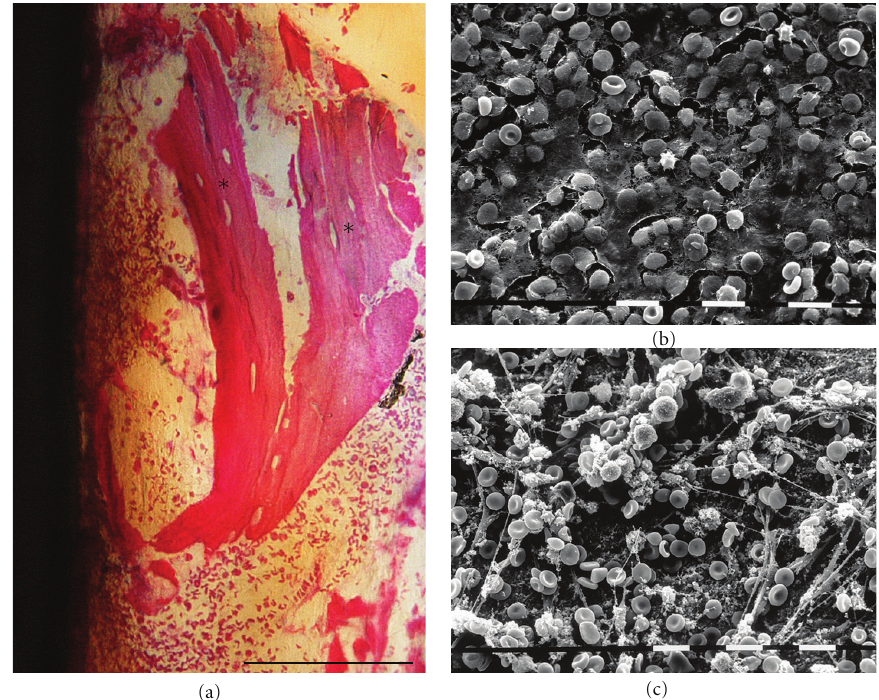
Figure 3: Day 0. Histology of longitudinal ground section (a). Empty osteocytic lacunae ( ∗ ). LM, toluidine blue, and acid fuchsin staining. Bar = 100 µ m. SEM images of MS (b) and SLA (c) surfaces extracted at 4 hours after insertion. Bar = 10 µ m.